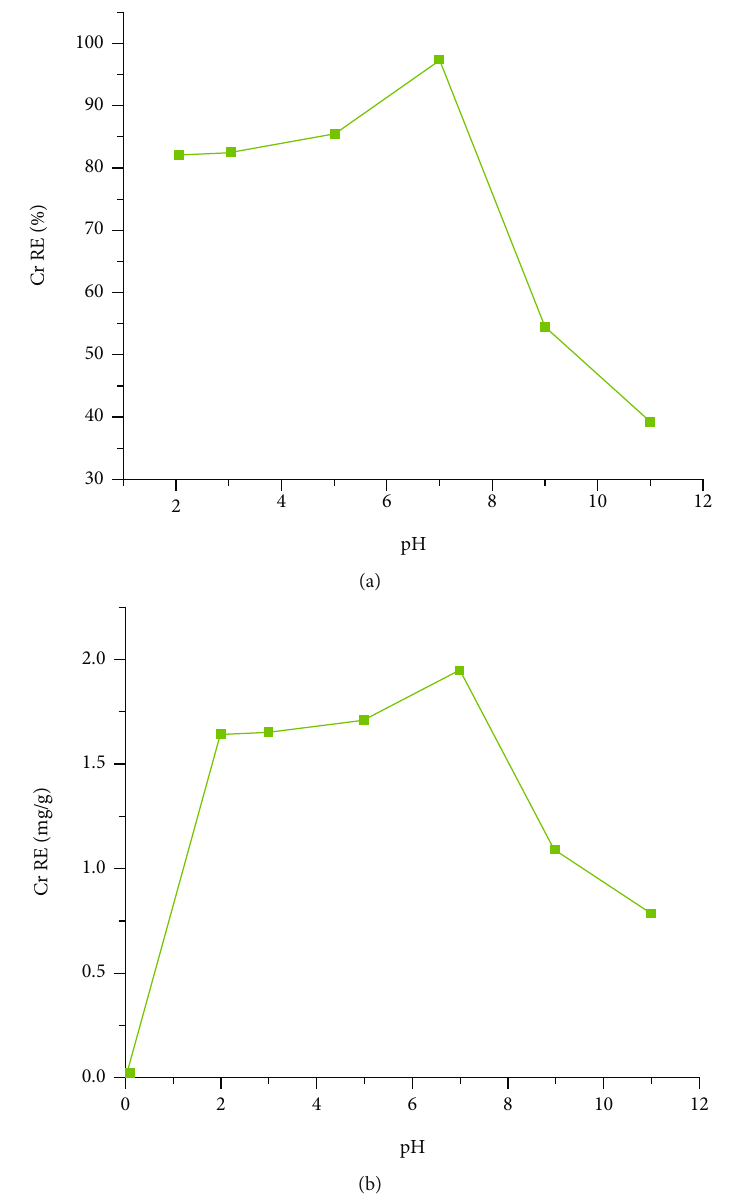
Figure 7: pH e ff ects on Cr (a) % RE and (b) mass adsorption e ffi ciency (mgg -1